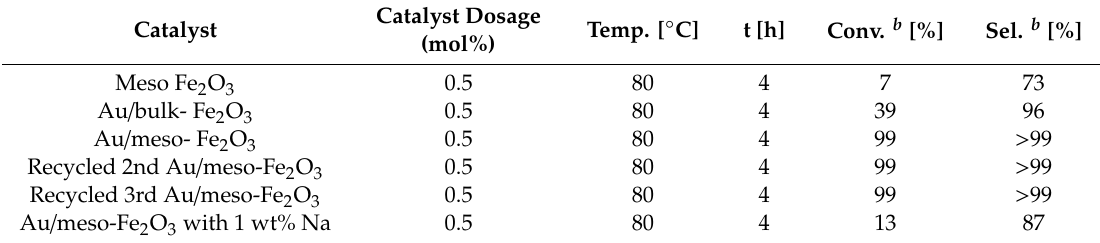
Table 2. Oxidation of 1-phenylethanol to acetophenone using mesoporous iron-based catalysts a . Catalyst